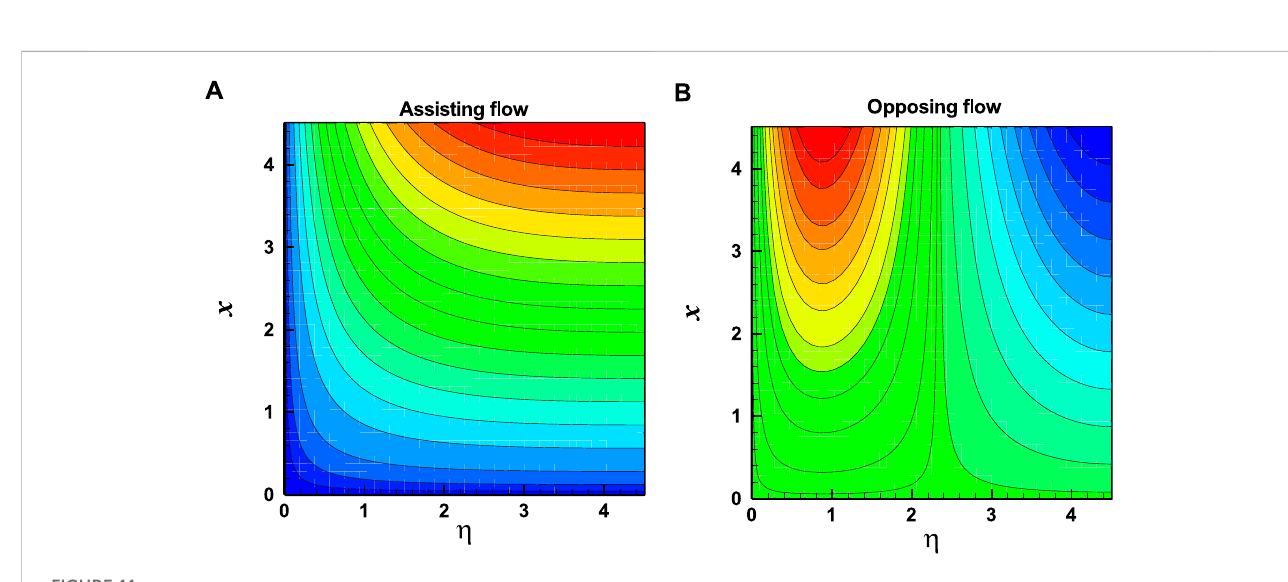
FIGURE 11 Variation of streamlines for assisting and opposing fl ow with Nb (cid:1) 0 . 3 , Nt (cid:1) 0 . 5 , Le (cid:1) 1 , Pr (cid:1) 3 . 97 , β (cid:1) γ (cid:1) 0 . 3 , Nc (cid:1) 0 . 5 , Gr (cid:1) 0 . 5 , M (cid:1) 0 . 5.